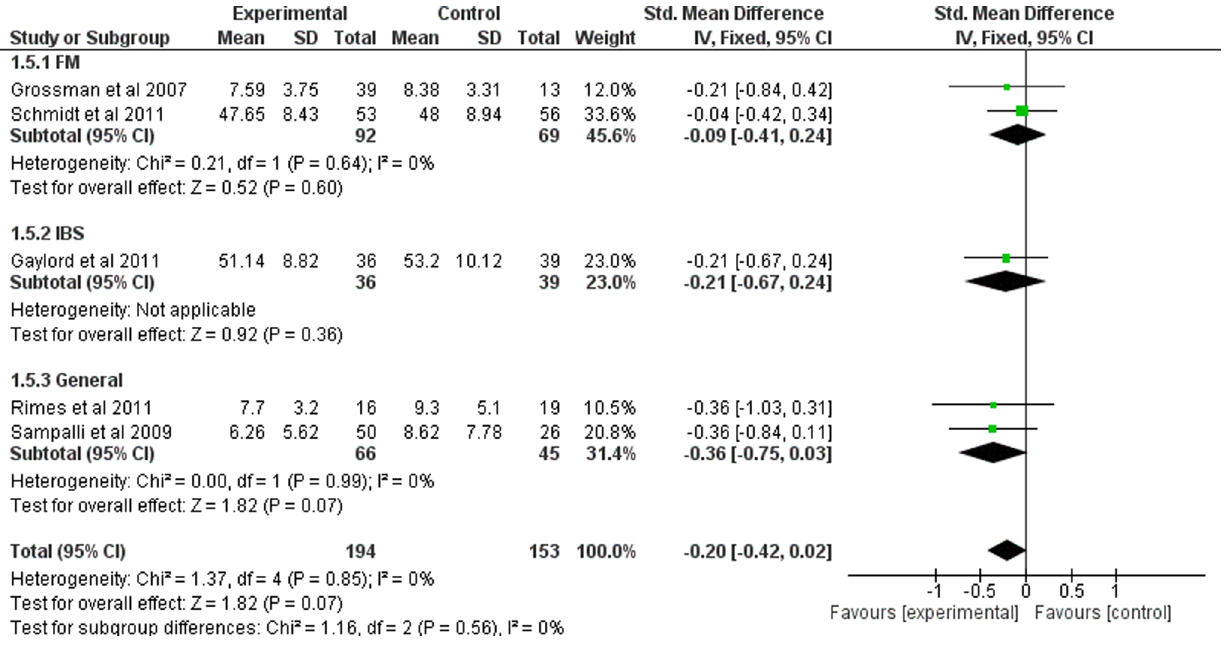
Figure 12. Forest plot showing the effect of mindfulness therapy on the anxiety outcome measure . Standardised mean difference between experimental and control group indicates that the mindfulness-based therapy group had no statistically significant differemce than the control group.